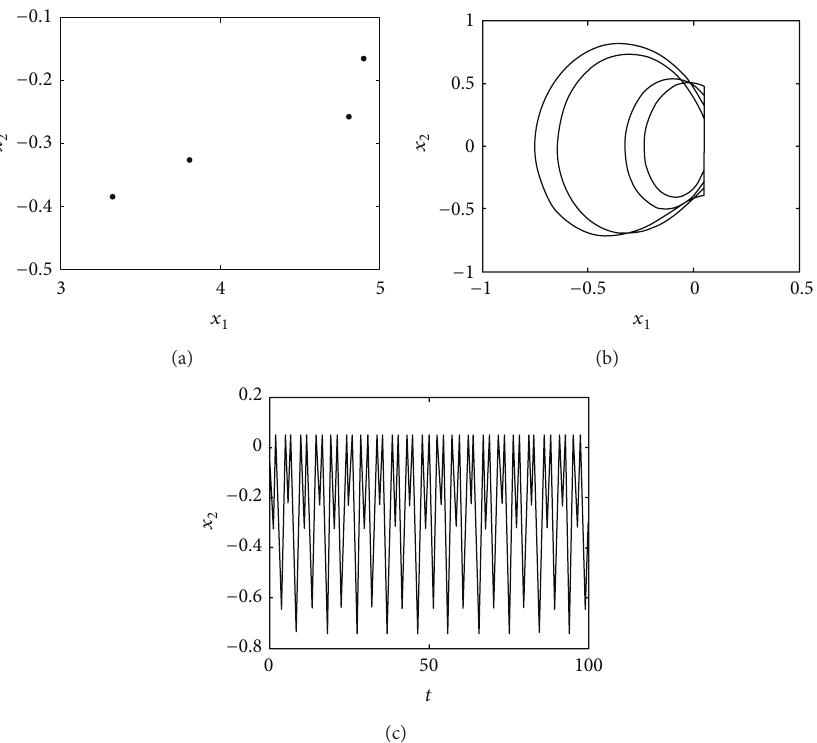
Figure 5: Poincar ´ e map, phase portrait, and time course diagram of the system with 𝜔 = 2.635